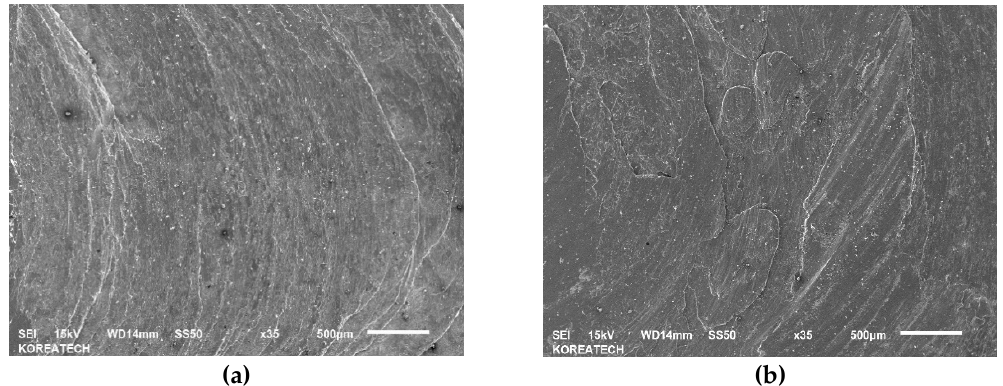
Figure 2. Pictures of fillers with four different diameters: 5.5 mm ( a ), 4.5 mm ( b ), 3.5 mm ( c ) and 2.5 mm ( d ).